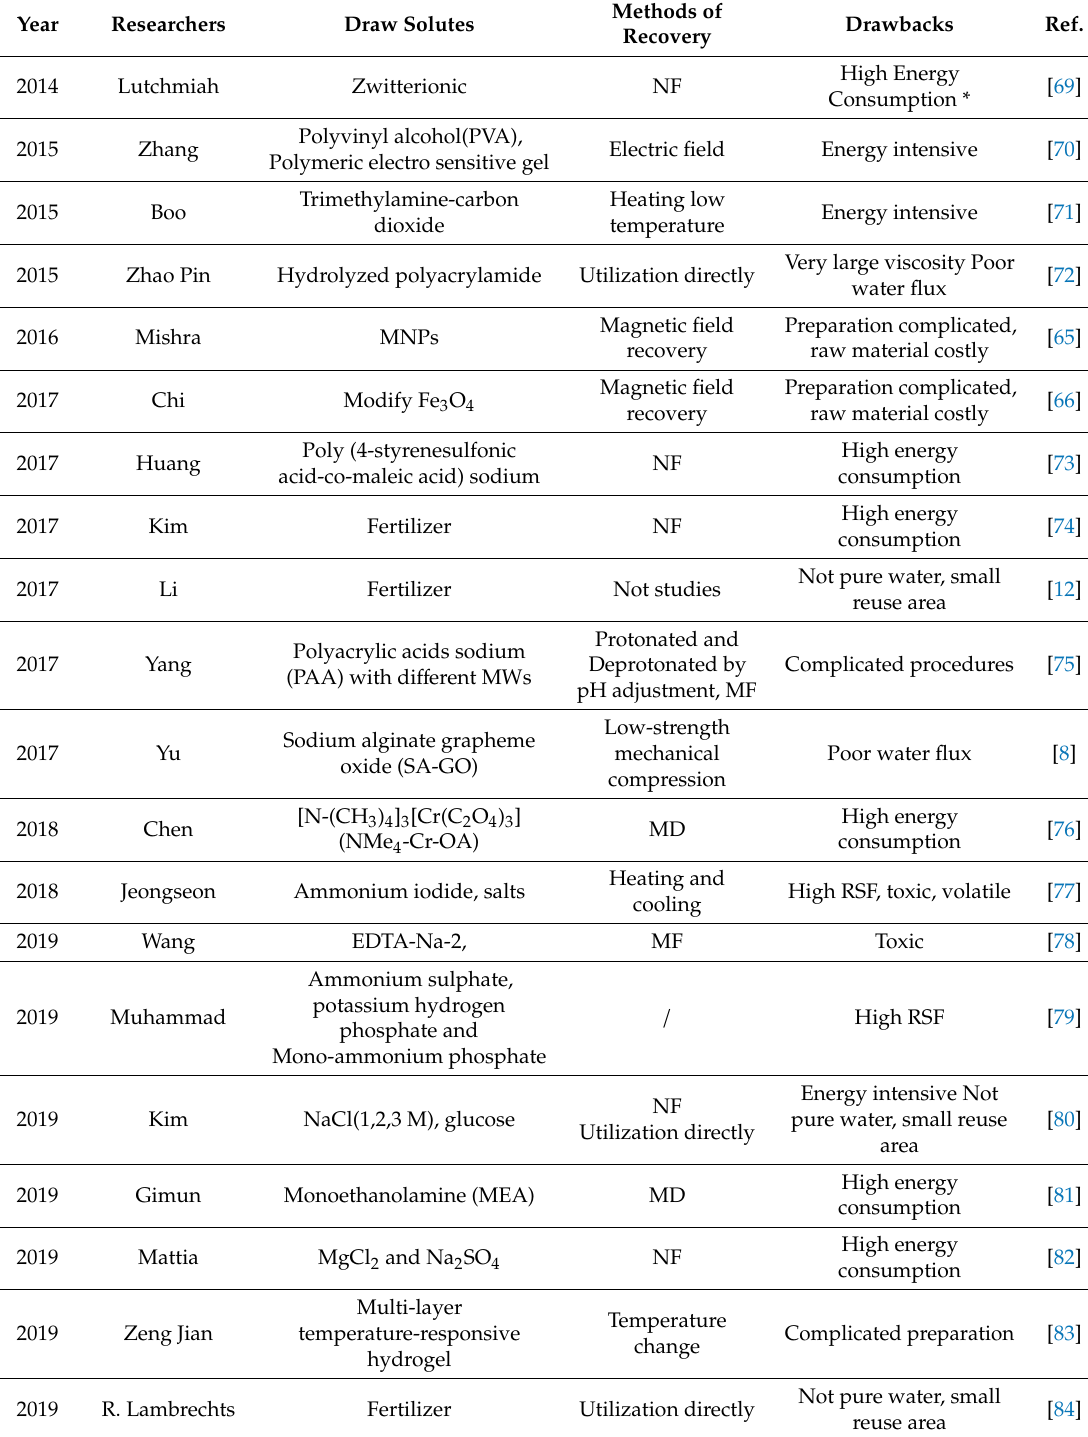
Table 2. Overview of development and recovery approaches to draw solutes used in FO